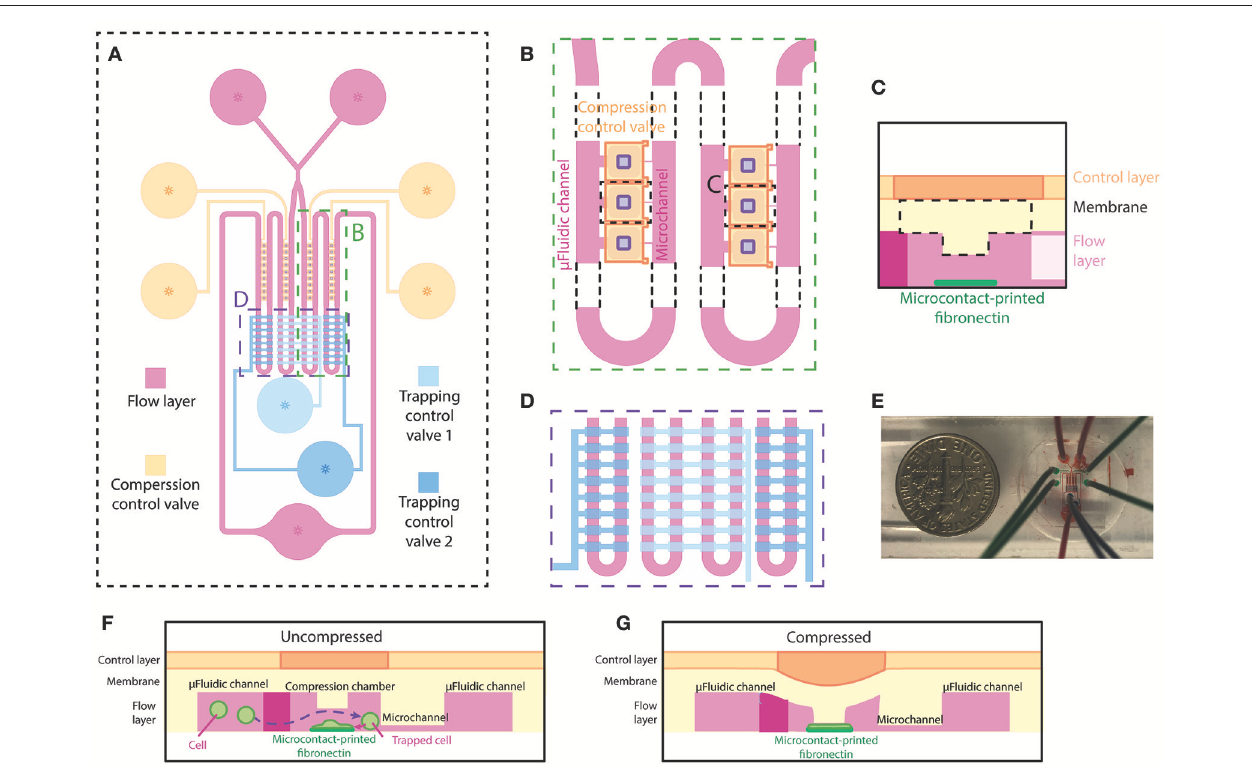
FIGURE 1 | Overview and design of the microfluidic device for single-cell compression. (A) The top view of overall design of the device. The flow layer is labeled in magenta, and the control layer consists of trapping control valves (blue) and compression control valve (orange). (B) The zoomed-in top view of the compression chamber (marked in A) and the meandering microfluidic channel in the device. The orange compression control valve is on top of the compression chamber in the flow layer. The purple rectangles are the designed block attached to the deflection membrane for compression. (C) Side view schematic of the compression chamber. A rectangular block and fibronectin island are unique features of this device. (D) The zoomed-in top view of the main meandering microfluidic channel (marked in A) and trapping control valve (blue). The inside two columns and outside two columns are controlled separately by two different trapping control valves. (E) A picture of the device. (F,G) Side view schematics of the device when the compression control valve is uncompressed (F) or compressed (G) on a cell spread on the fibronectin